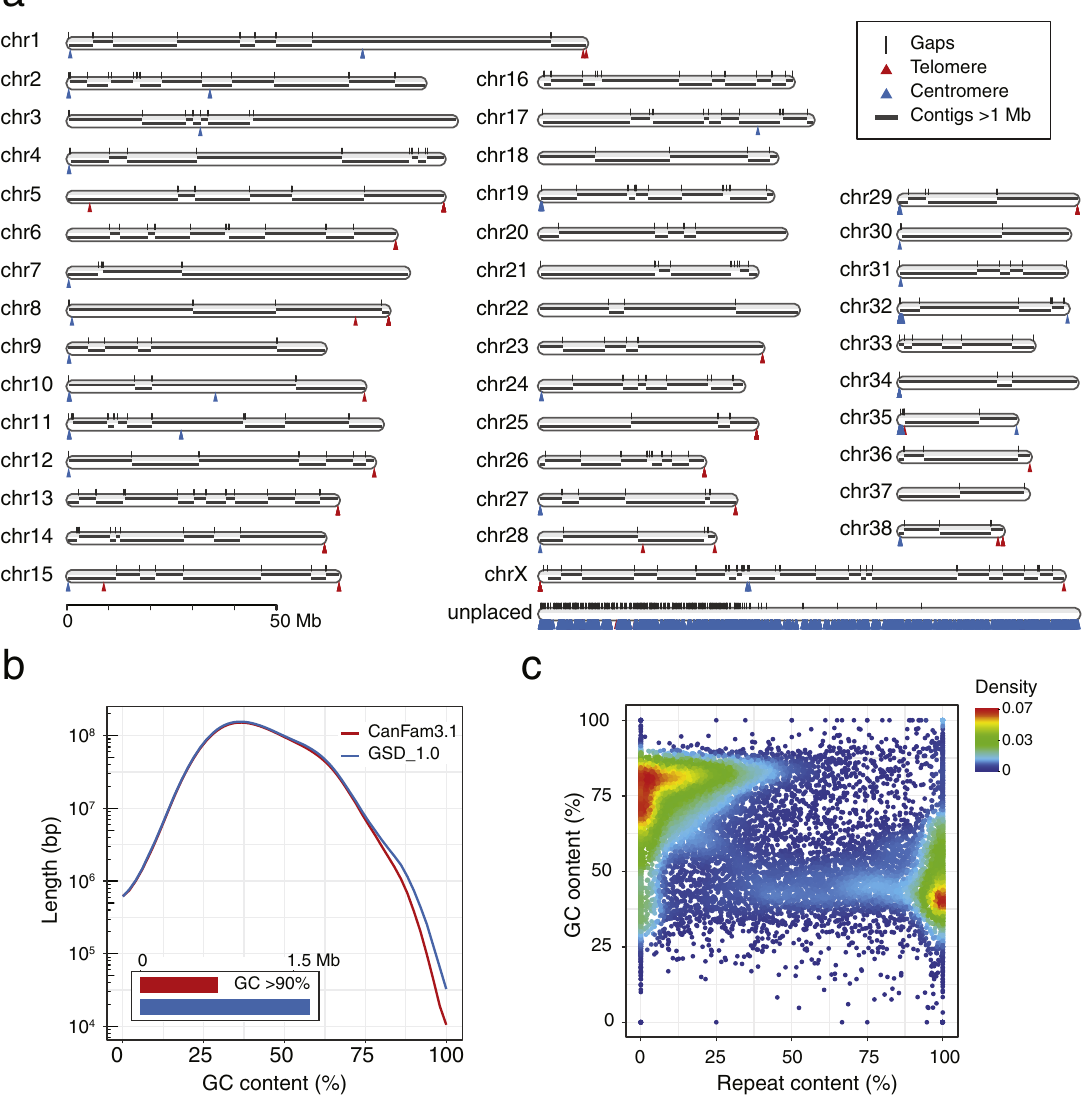
Fig. 1 Features of the novel canine assembly. a GSD_1.0 ideogram showing chromosomes, contigs, gaps, centromere and telomere repeats. All unplaced sequences were concatenated into a single scaffold (segmental duplications, 58.1%; centromeric repeats, 30.1%). b Comparison of GC content (50bp window) between GSD_1.0 and CanFam3.1. c Sequence characteristics of fi lled CanFam3.1 gaps in GSD_1.0. These are predominately high in GC or repeat content. Table 1 Assembly statistics of GSD_1.0 compared to